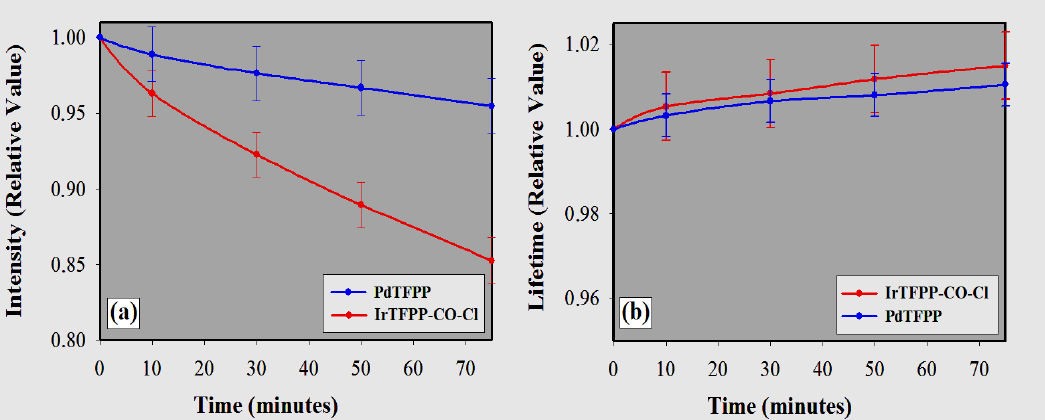
Figure 9. Measured phosphorescence (photobleaching) of polystyrene O 2 optodes at 405 nm (continuous illumination, power dissipation of LED ≈ 68 mW). The values of the vertical axes are relative to the initial values (referenced as one) for both ( a ) intensity and ( b )